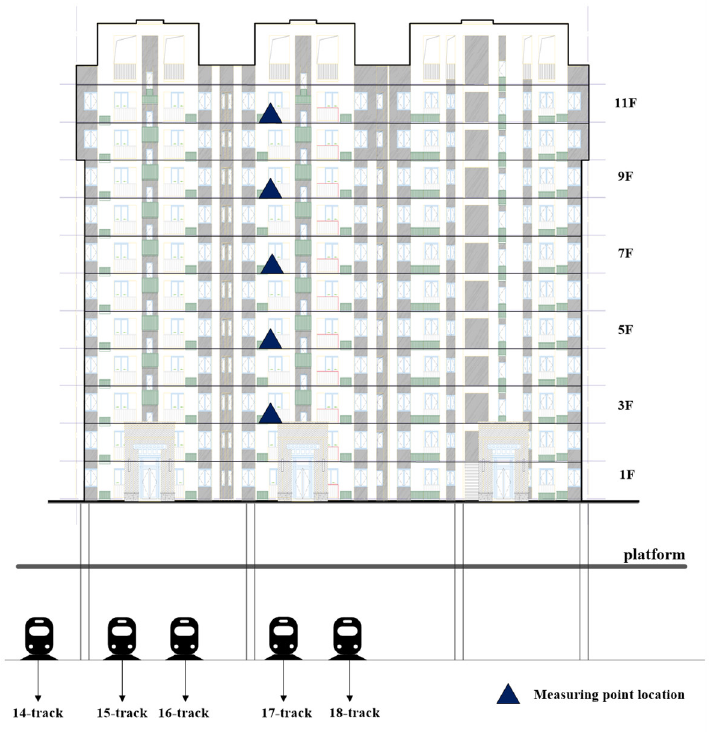
Figure 3. The sectional view of the over-track building.